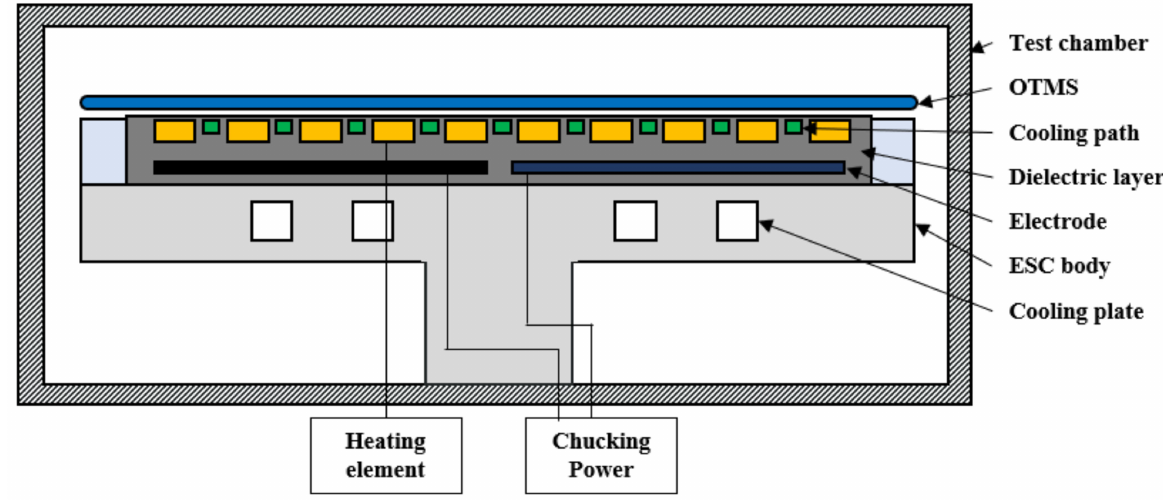
Figure 8. Schematic of ESC temperature distribution measurement test.